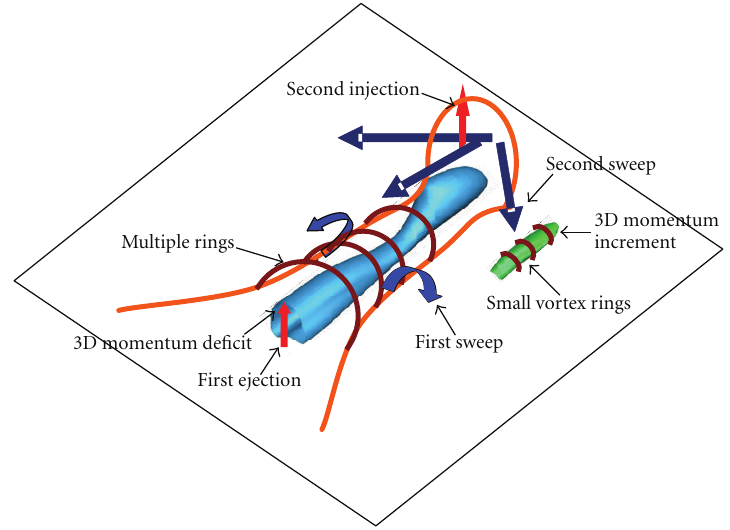
Figure 33: Sketch of mechanism of multiple rings formation and small vortices formation.